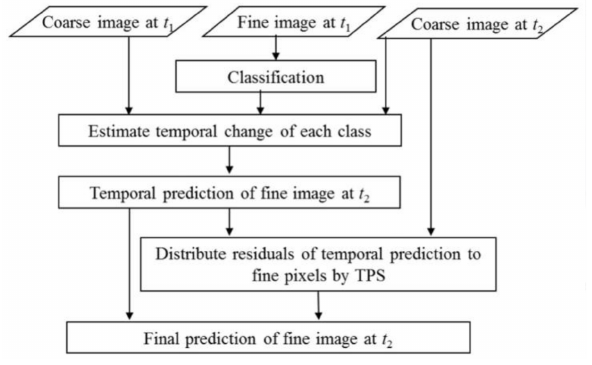
Figure 1. Flowchart of the Flexible Spatiotemporal Data Fusion (FSDAF) fusion algorithm. Figure reproduced from [8].